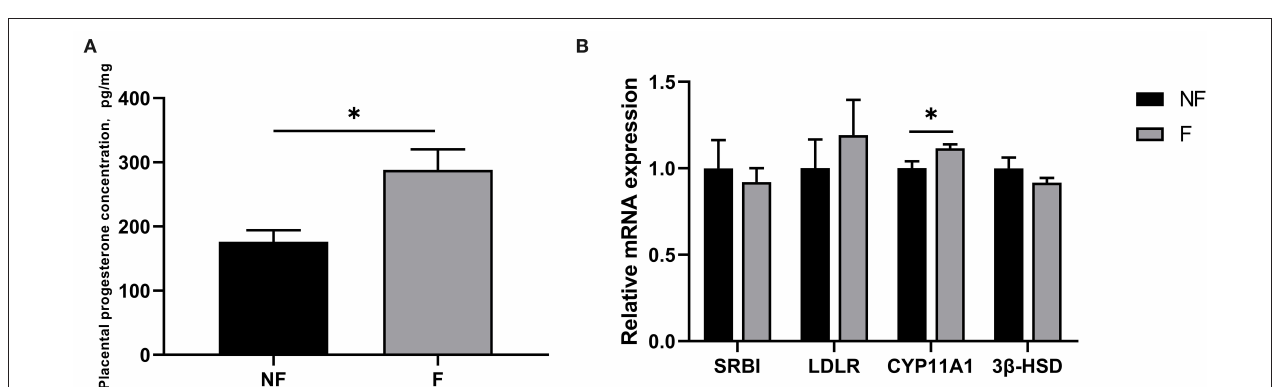
FIGURE 4 | Effects of fiber supplementation in gestation diet on serotonin synthesis and transport in sow placenta. (A) TPH concentration; (B,C) Gene expression of TPH1 and SERT; (D,E) Protein expression of TPH1 and SERT measured using immunohistochemistry. NF, sows fed with a semi-purified basal diet (0.01% dietary fiber); F, sows fed with a semi-purified basal diet supplemented with 8.33 g/kg inulin and 200 g/kg cellulose. TPH, tryptophan hydroxylase; SERT, serotonin transporter. Values are mean ± standard error ( n = 5). Significant differences are displayed in the figures by * P < 0.05.